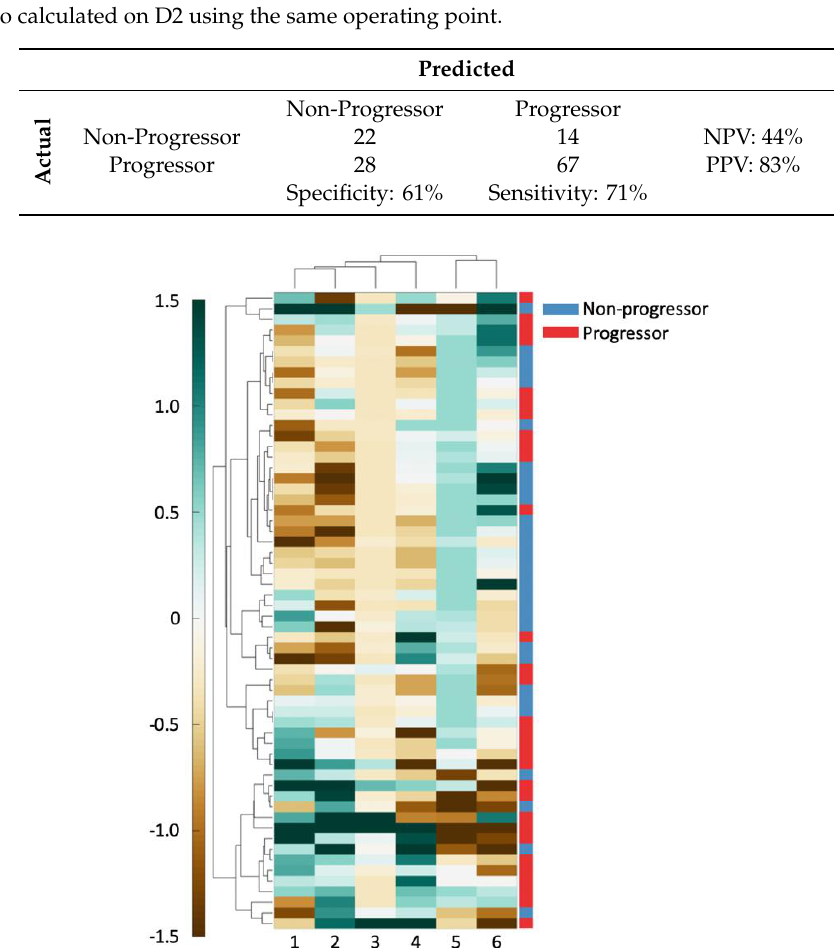
Figure 2. The 6 features used to create a clustergram on D 1 . Features and patients were clustered hierarchically. The shading of each cell shows the relative over- or under-expression of that feature in a patient. From left to right, the features are: (1) standard deviation of minimum / maximum nuclear radius, (2) minimum / maximum nuclear perimeter, (3) minimum / maximum ratio of Voronoi polygon perimeter, (4) standard deviation of nuclear shape’s Fourier descriptor 6, (5) tensor contrast inverse moment range, and (6) standard deviation of Voronoi polygon